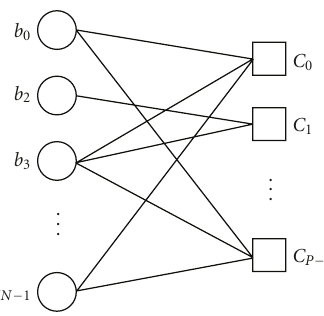
Figure 4: Example of a Tanner